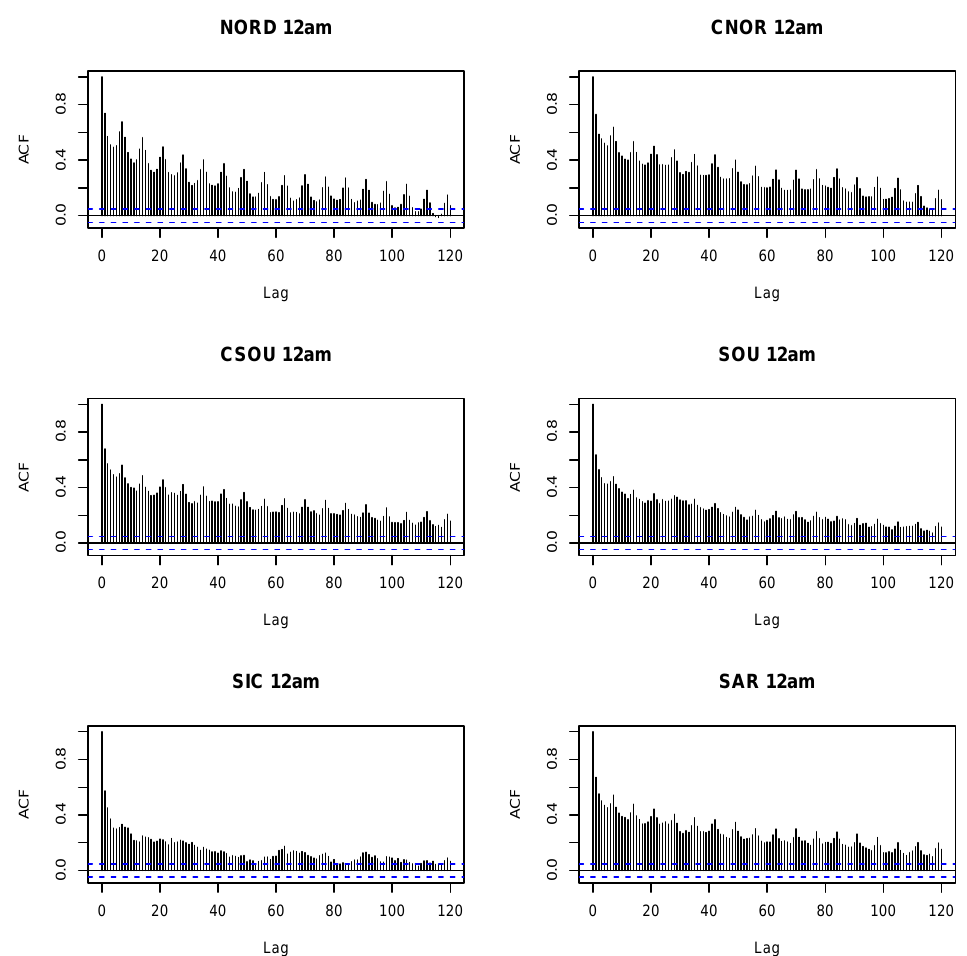
Figure 4. Time series of spot prices observed in the North zone at Noon (12 a.m.). Many authors indicate mean reversion (see, for instance, [10,12]) as a typical